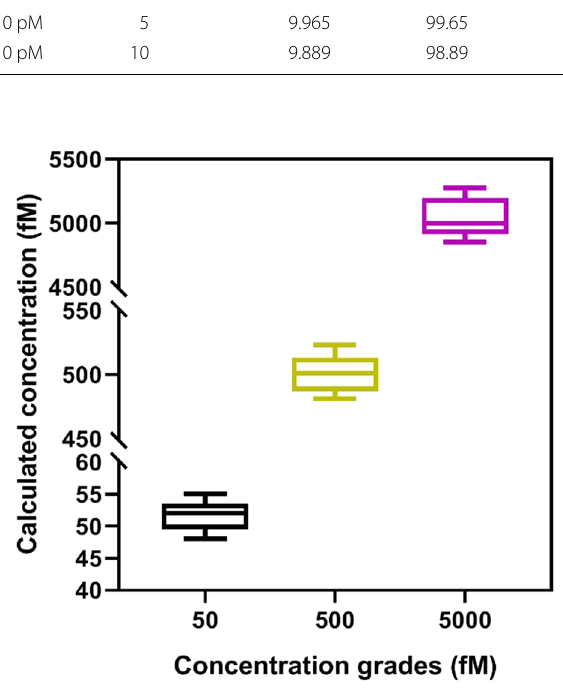
Fig. 5 Calculated concentration of target miRNA by